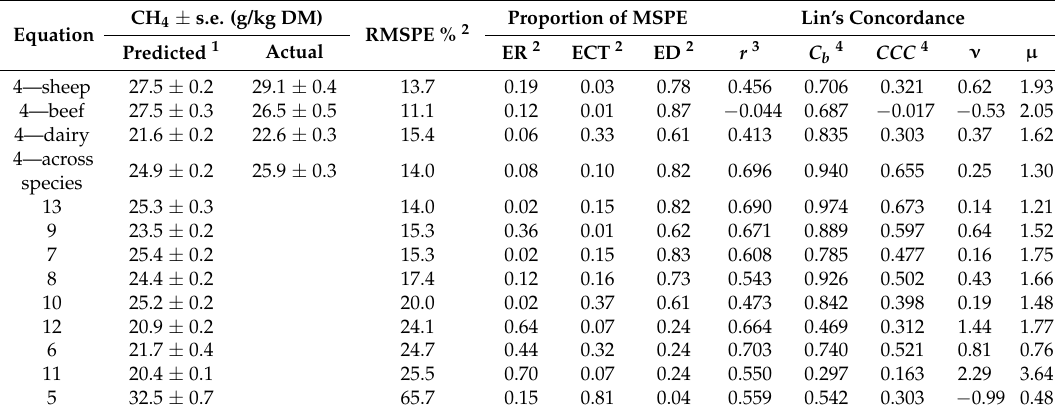
Table 4. Evaluation of prediction equations for CH 4 emissions developed in the present study and developed elsewhere (Table 3), using data from sheep ( n = 96), beef ( n = 24) and dairy cattle ( n =